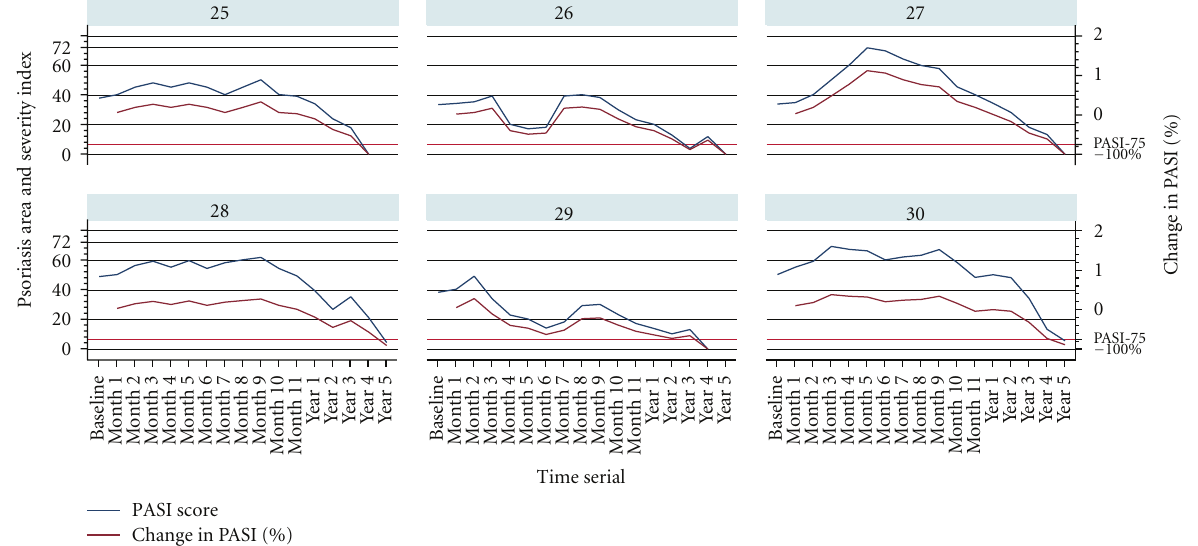
Figure 3: Psoriasis area and Severity index scores and percentage change in PASI from the baseline screening to month 60 in psoriasis patients with prior immunosuppressive therapy. 176 of 1199 patients with prior immunosuppressants therapy completed the study and reached PASI75 improvement in 60 months treatment and followup. The two-way graphs of 176 patients were generated, to save the space, a random selection of 30 of 176 patients was presented herewith on the above twoway graphs, patients underwent 7-day washouts of previous immunosuppressant treatments before starting herose, the severity of diseases flared up to a high point initially, and all patients (1199) experienced mean 110% (range from 55% to 240%) worsening of PASI score relative to baseline, but henceforth progressively tapered down when immunosuppressant withdrawal syndrome had